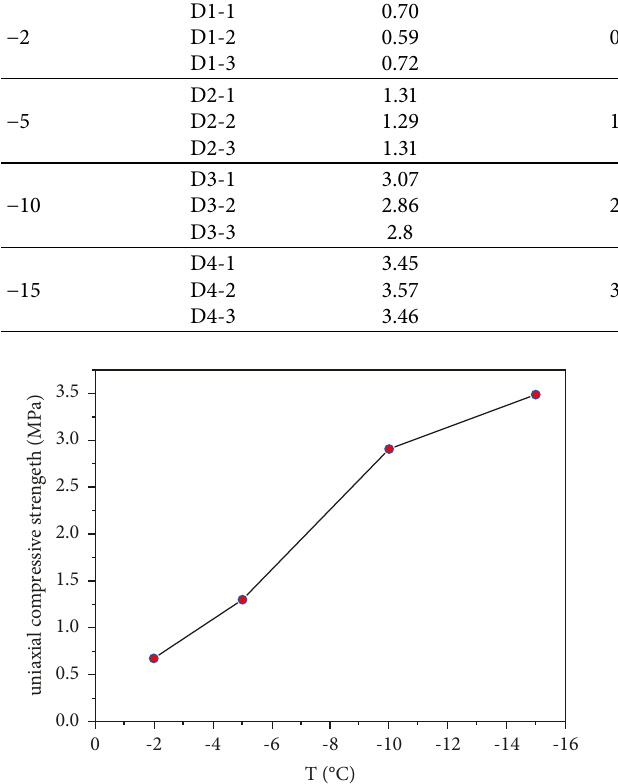
Figure 4: The change of uniaxial compressive strength with temperature.